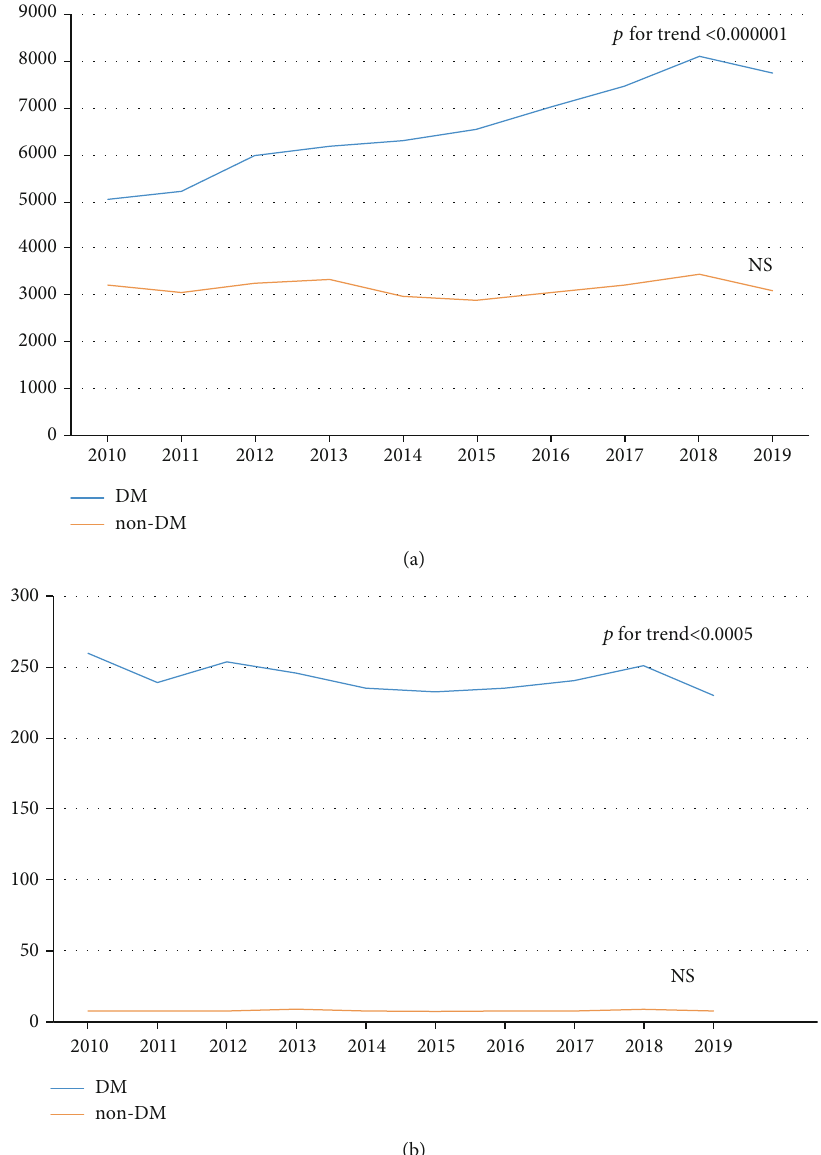
Figure 1: (a) Absolute number of amputations in patients with and without diabetes, and (b) number of amputations in patients with diabetes per 100,000 diabetics, and in patients without diabetes per 100,000 inhabitants in the years